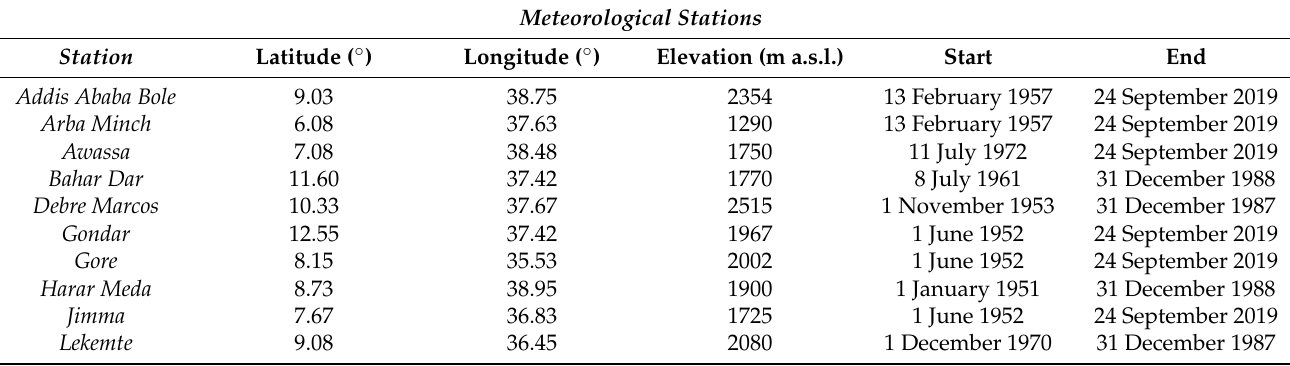
Table 2. Meteorological stations of National Oceanic and Atmospheric Administration (NOAA) used in the study. Meteorological Stations